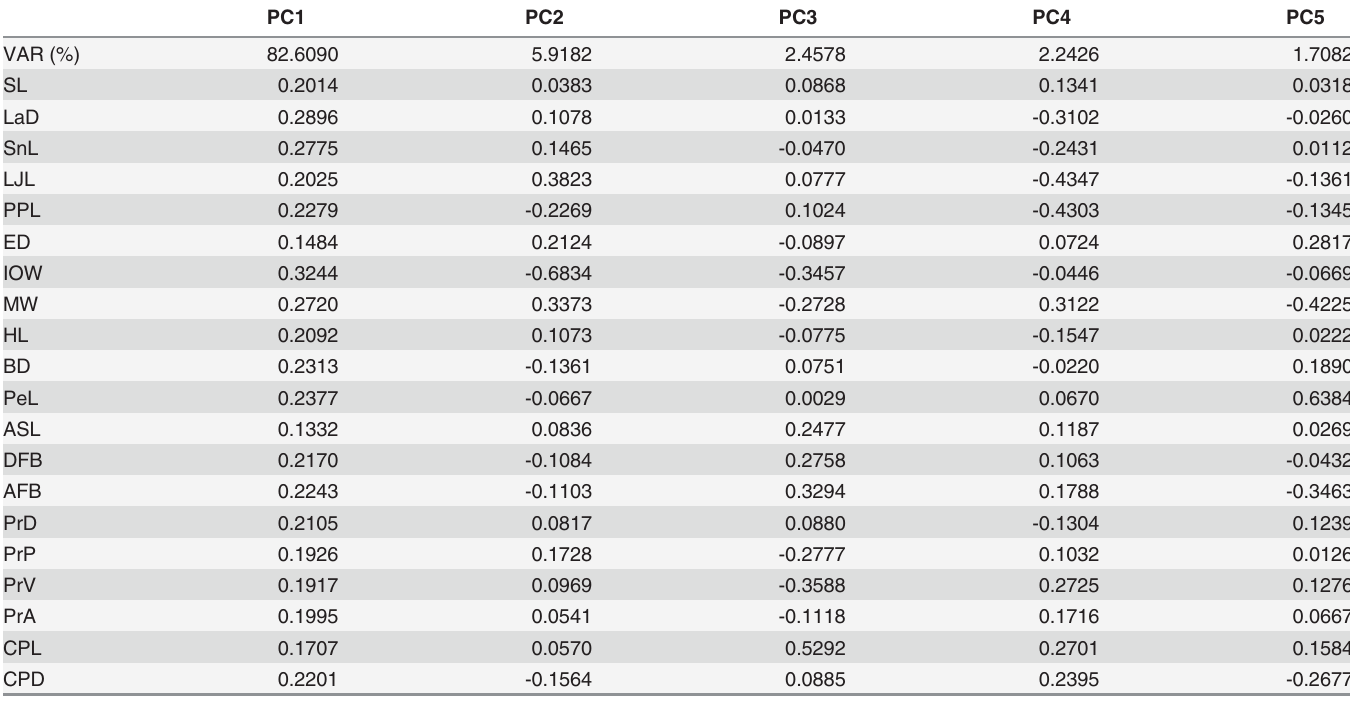
Table 3. PCA on measurements of the inter-specific